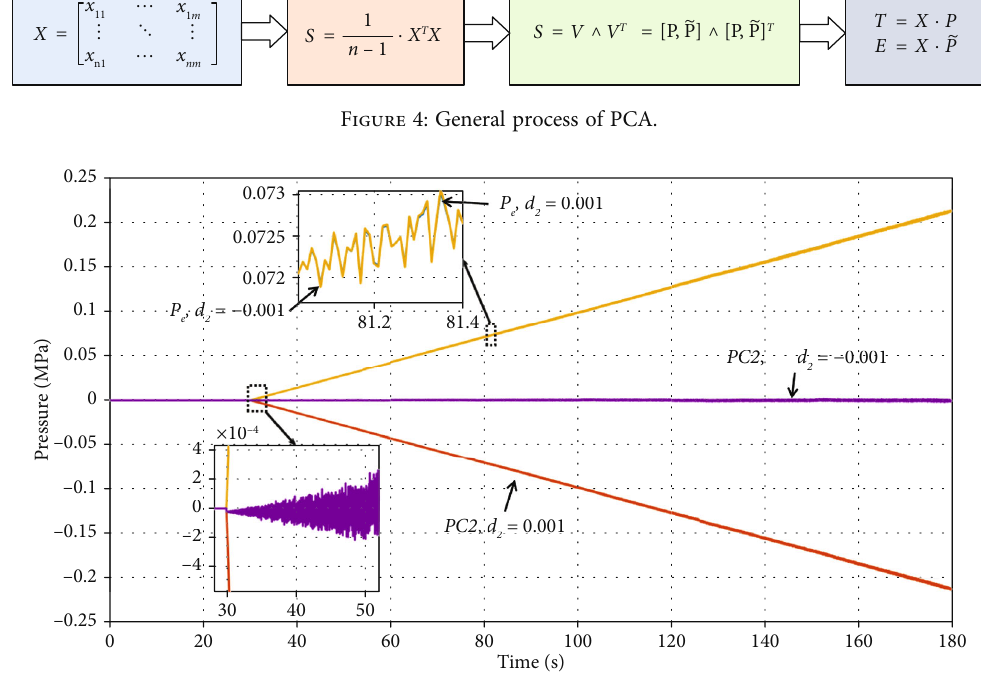
Figure 5: The PC2 and Pe under di ff erent fault